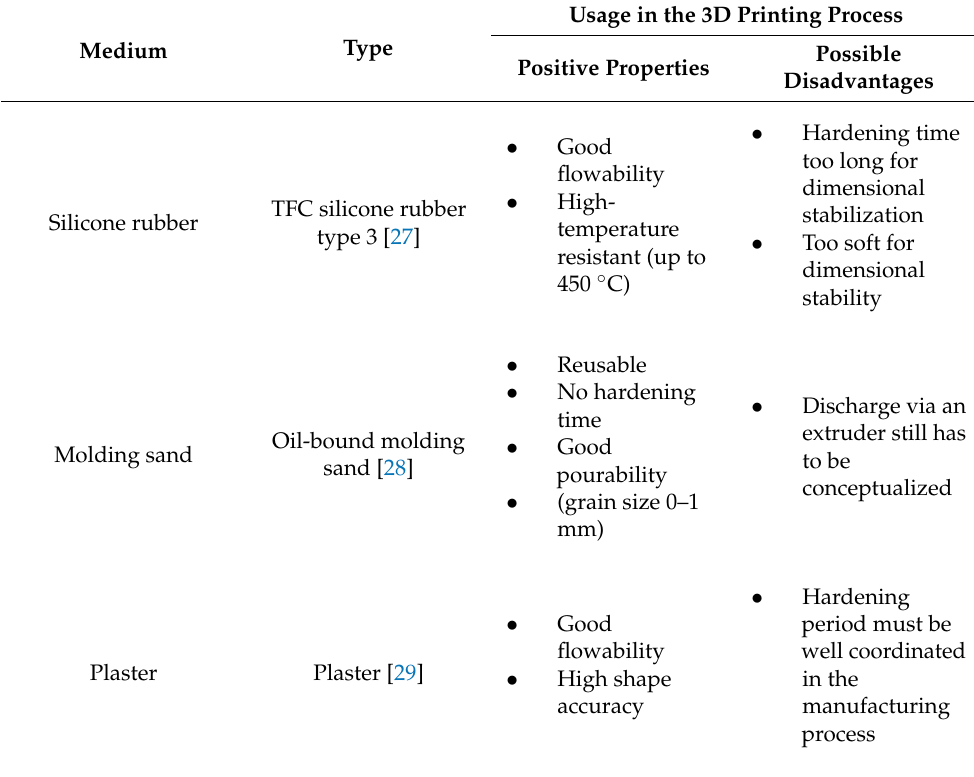
Table 1. Selected media serving as media for dimensional stabilization (MDS) with properties, advantages, and possible disadvantages for the additive manufacturing process of rubber.